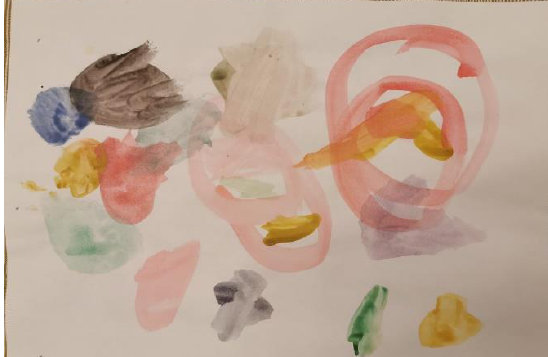
Figure 2. Drawing without the augmentation.